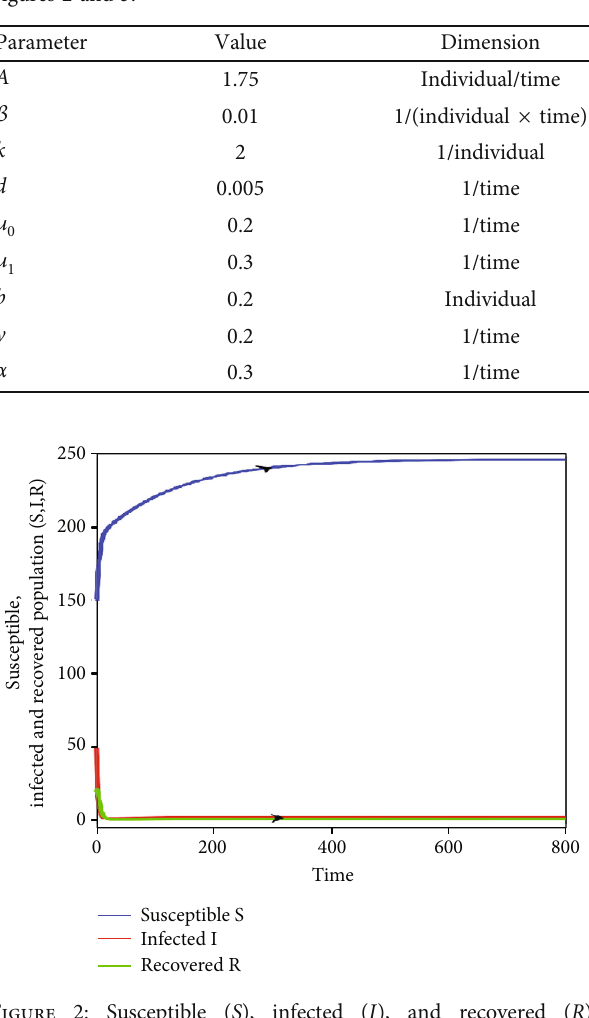
Table 1: Random parameters used in the numerical simulations in Figures 2 and 3.